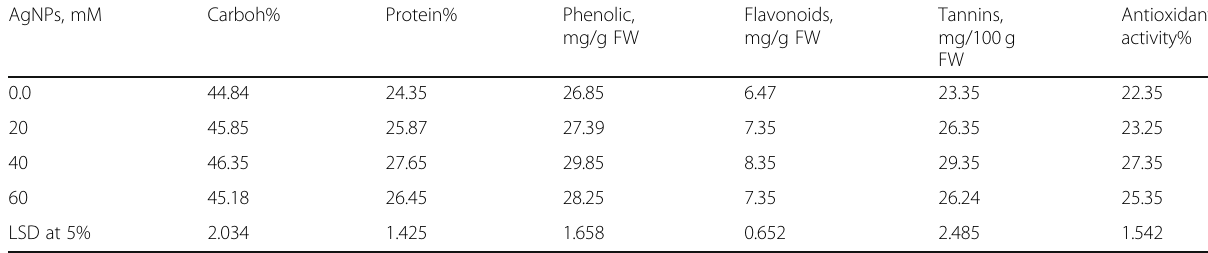
Table 4 Effect of different concentrations of AgNPs on biochemical constituents of the yielded seeds of fenugreek plants (means of two seasons) AgNPs,